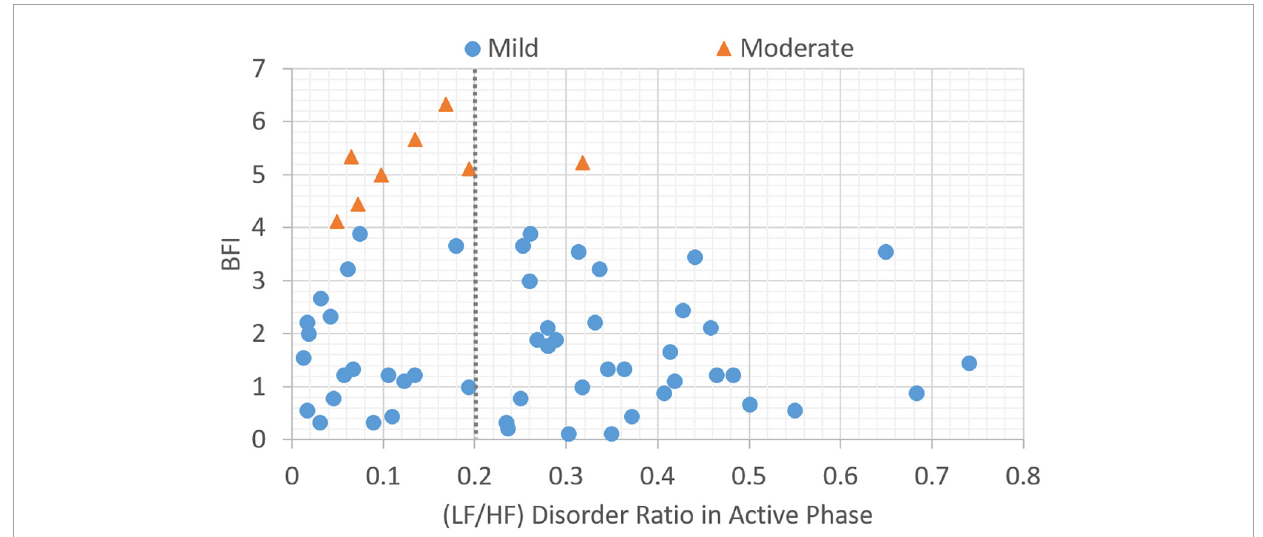
FIGURE4 Plot of data distribution between BFI and (LF/HF) disorder ratio in active phase; circles represent cases with mild fatigue (BFI < 4), and triangles represent cases with moderate fatigue (BFI ≥ 4). The dotted line illustrates a boundary line with cutoff point, LHDA = 0.2.